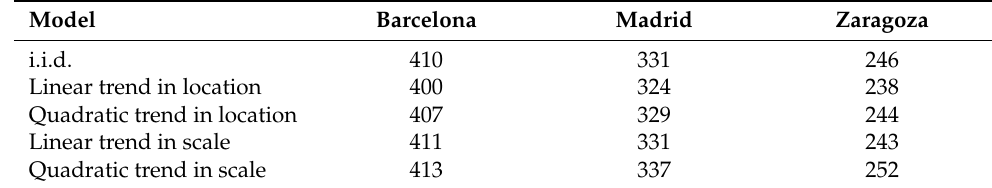
Table 3. DIC of GEV models including constant and time-varying location and scale parameters.